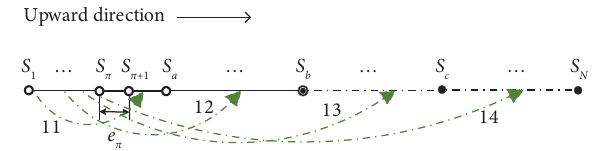
Figure 4: Travel path of passengers taking V e ,e ∈ I. π π